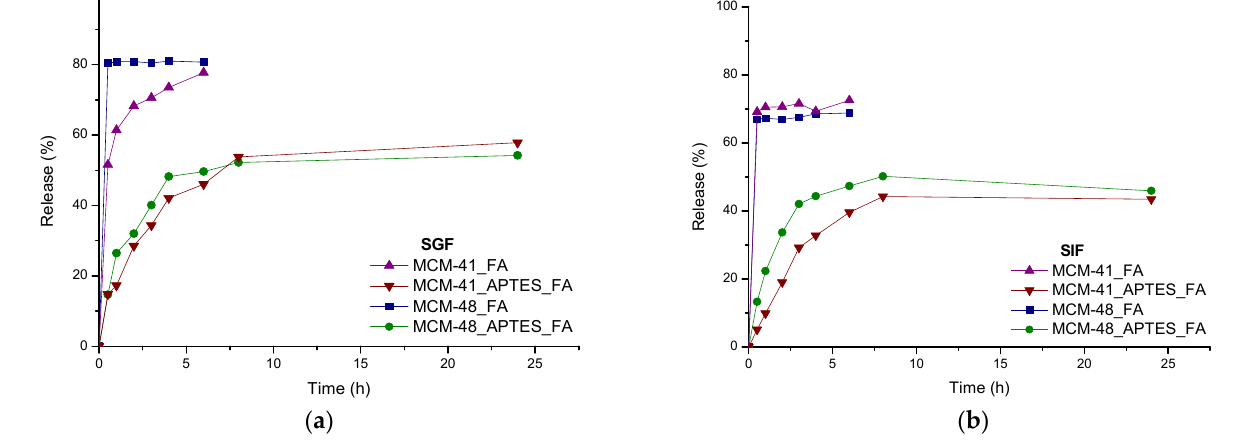
Figure 10. Release profiles for FA from the MCM-41_FA; MCM-41_APTES_FA; MCM-48_FA; MCM-48_APTES_FA samples in SGF ( a ) and SIF ( b ).